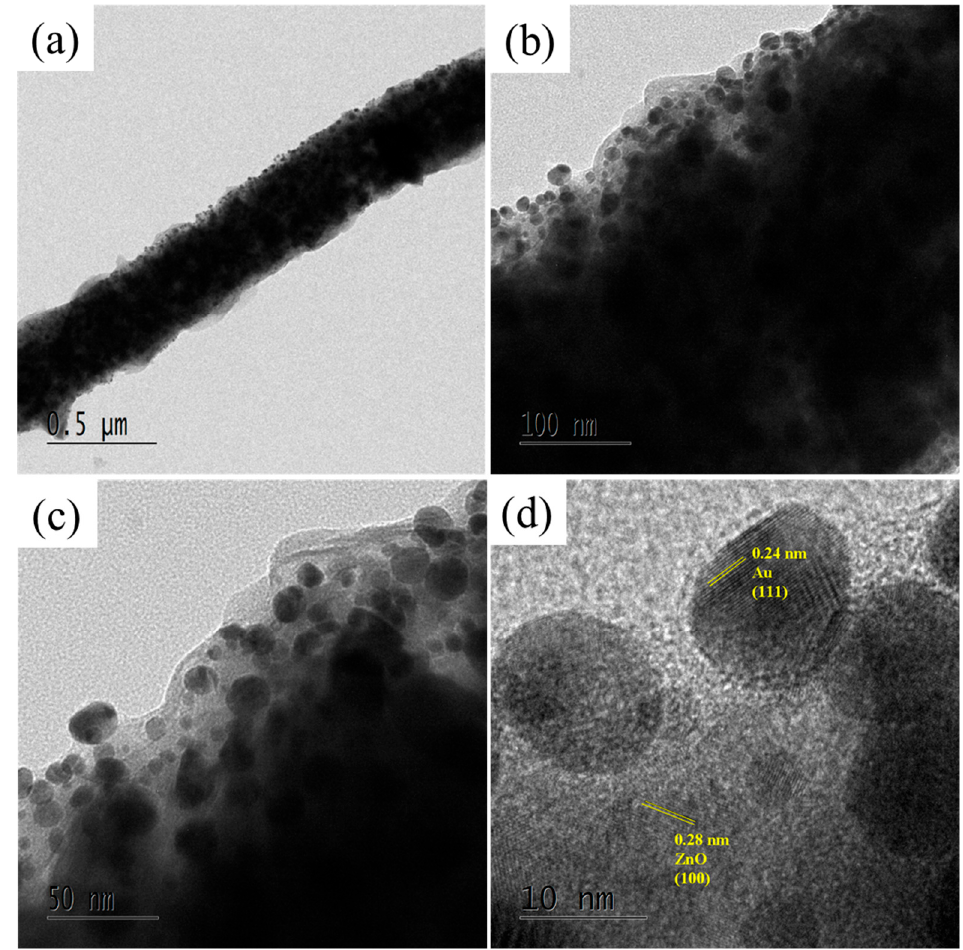
Figure 2. ( a )–( c ) TEM micrographs of Au ‐ decorated ZnO ‐ PANI (25 wt.%) composite nanofibers at Figure 2. ( a – c ) TEM micrographs of Au-decorated ZnO-PANI (25 wt.%) composite nanofibers at three different magnifications; ( d ) corresponding HRTEM image. three different magnifications; ( d ) corresponding HRTEM Figure 3a indicates the EDS analysis of the Au ‐ decorated ZnO ‐ PANI (25 wt.%) com ‐